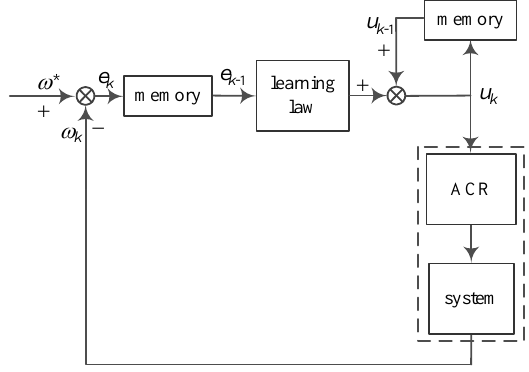
Figure 1. The block diagram of the Figure 1. the block diagram of the controller.